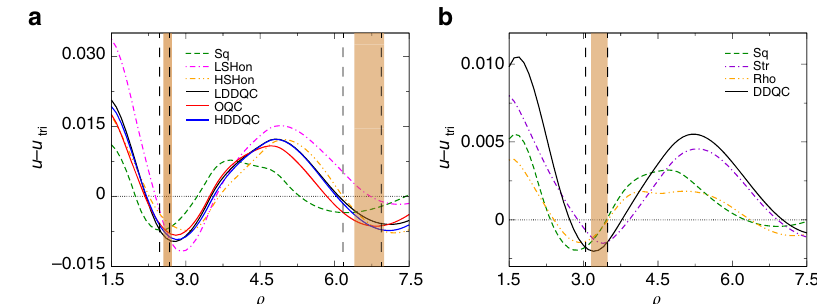
Fig. 6 Comparison of the potential energies of the zero temperature QCs and neighboring solids. a and b are for α = 2.0 and α = 2.5, respectively. The potential energy per particle u is subtracted by that of a perfect triangular lattice, u tri . The horizontal dotted line marks u = u tri . The density regimes demarcated by the vertical dashed lines and brown bands are where QCs have the lowest potential energy and where QCs exist, respectively. The absence of perfect match between the two may be due to